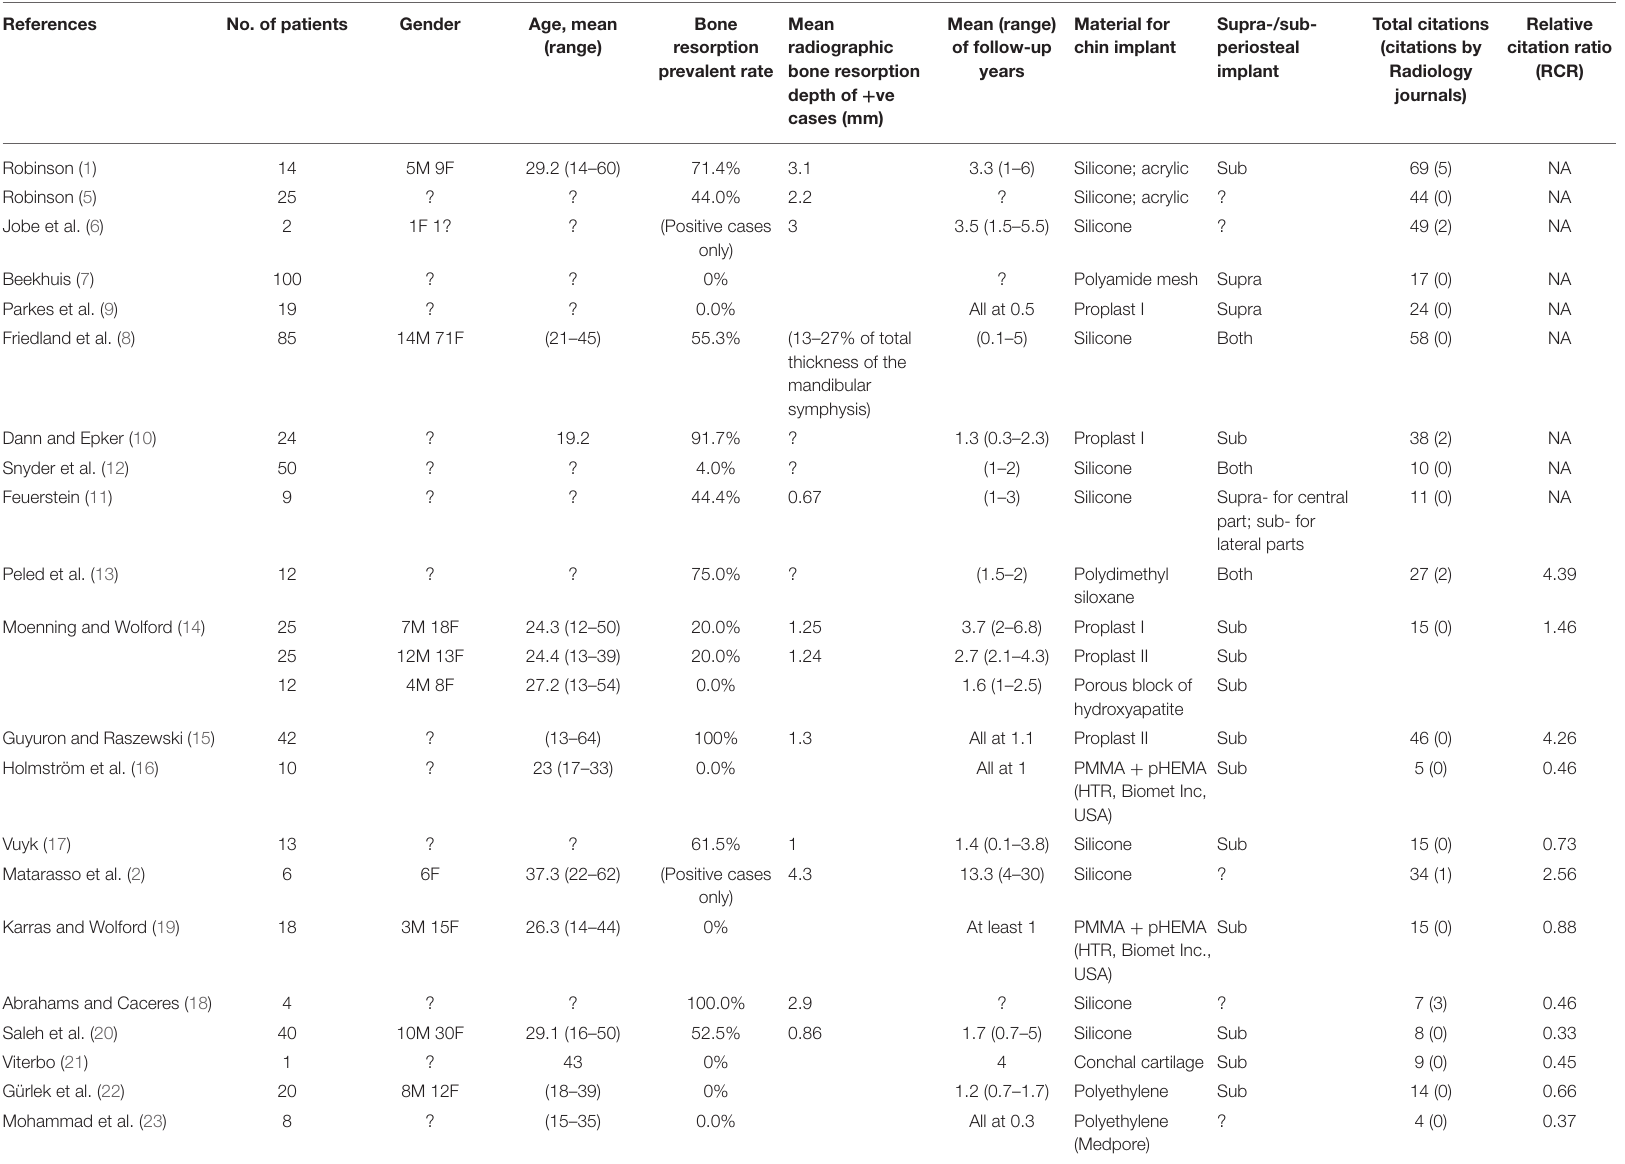
TABLE 1 | Details of the 28 included studies of reporting mandibular bone resorption caused by chin